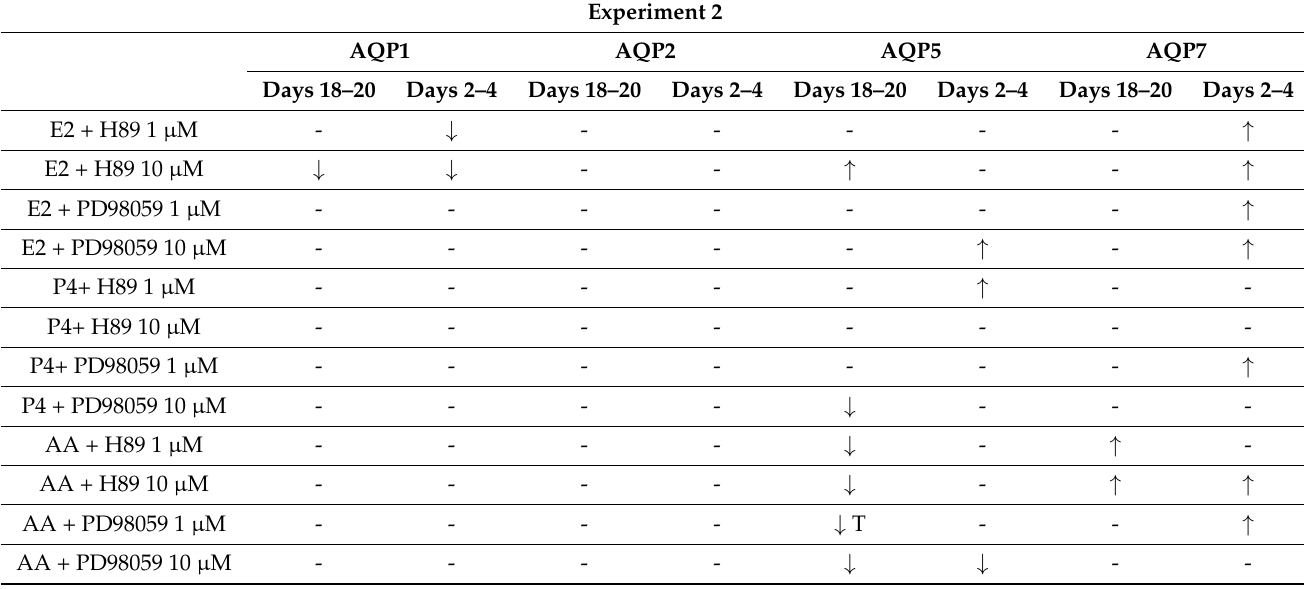
Table 4. A summary of the results from Experiment